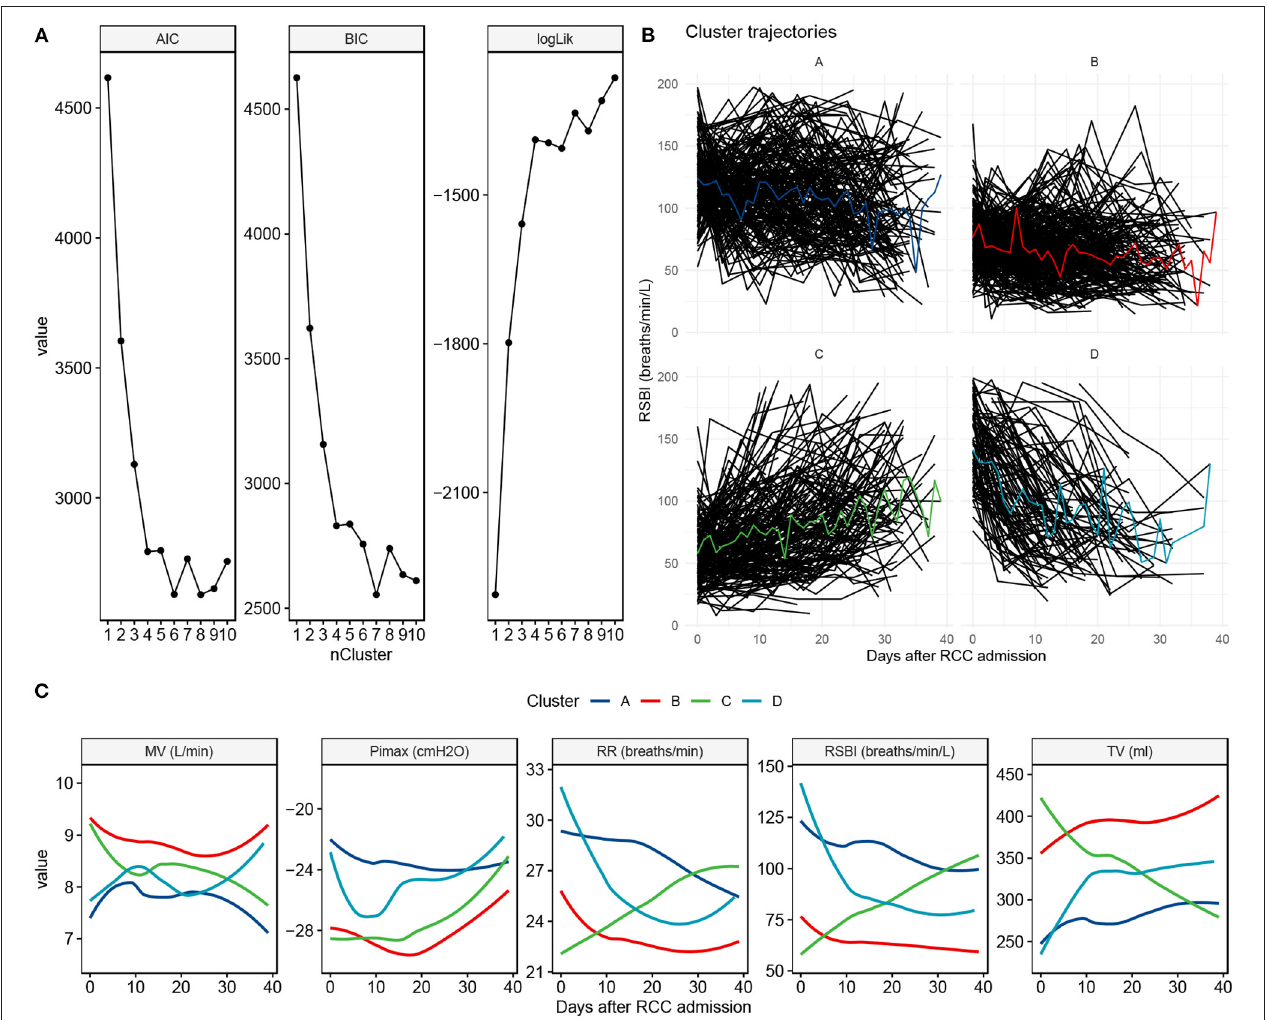
FIGURE 2 | Clustering to identify clusters of patients with prolonged mechanical ventilation. (A) The best number of clusters was chosen by using statistical metrics. Greater values of log likelihood indicate better model fit, whereas lower values of BIC and AIC indicate better model fit. (B) Trajectory characteristics of each cluster. Individual trajectories are represented by black lines and the cluster trajectory is colored. The cluster label and percentage are shown on the top of each panel. (C) Trajectory and 90% confidence interval for each of the ventilator parameters, stratified by the cluster membership. BIC, Bayesian information criterion; AIC, Akaike’s information criterion; MV, minute ventilation; Pimax, maximum inspiratory pressure; RR, respiratory rate; RSBI, Rapid shallow breathing index; TV, tidal volume.